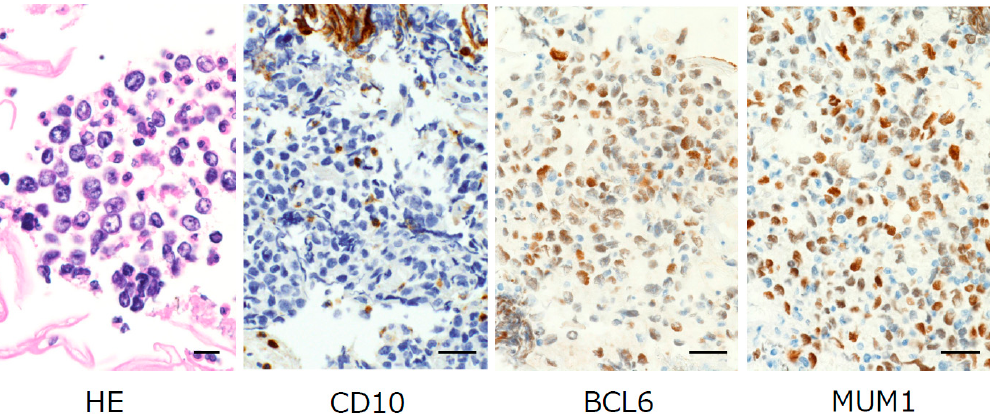
Figure 3. Hematoxylin–eosin (HE) staining of cell blocks showed large lymphocytes (magnification 40×, bar = 20µm). Immunostaining of cell blocks (magnification 20×, bar = 50µm) showed nuclear positivity for B-cell lymphoma 6 (BCL6), and multiple myeloma oncogene 1 (MUM1). The specimen was CD10-negative. We confirmed positive staining of CD79a, CD20, BCL2, and Ki67 in large lymphocytes that were identified by HE staining. Negative staining of CD3, CD25, CD30, and CD56 was not shown.